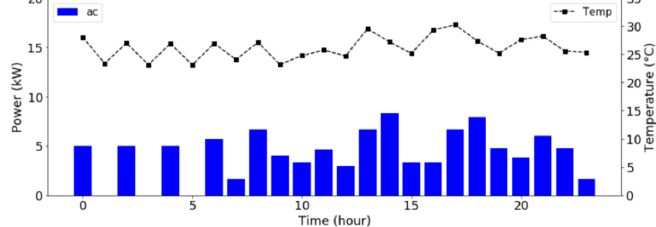
Figure 7. ( a ) Simulation results of washing machine and dish washer ( b ) Simulation results of EV charging/discharging power and PV curtailment, and ( c ) Simulation results of air conditioner and indoor temperature.